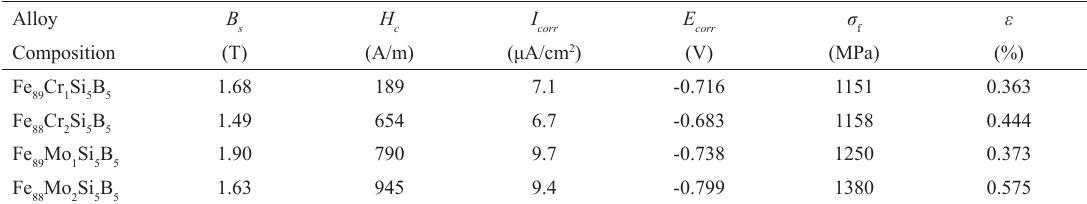
Figure 4: B-H hysteresis loops of Fe 2) ribbon as-spun alloys under an applied field of 800 kA/m. Table 1: Saturation magnetic flux density ( B strength (